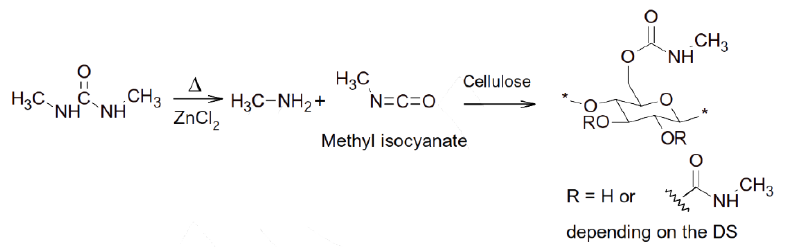
Figure 4. The proposed reaction mechanism for CMeC synthesis. Reprinted from reference [79] with permission. Table 1. Catalytic DESs used in biomass upgrading.